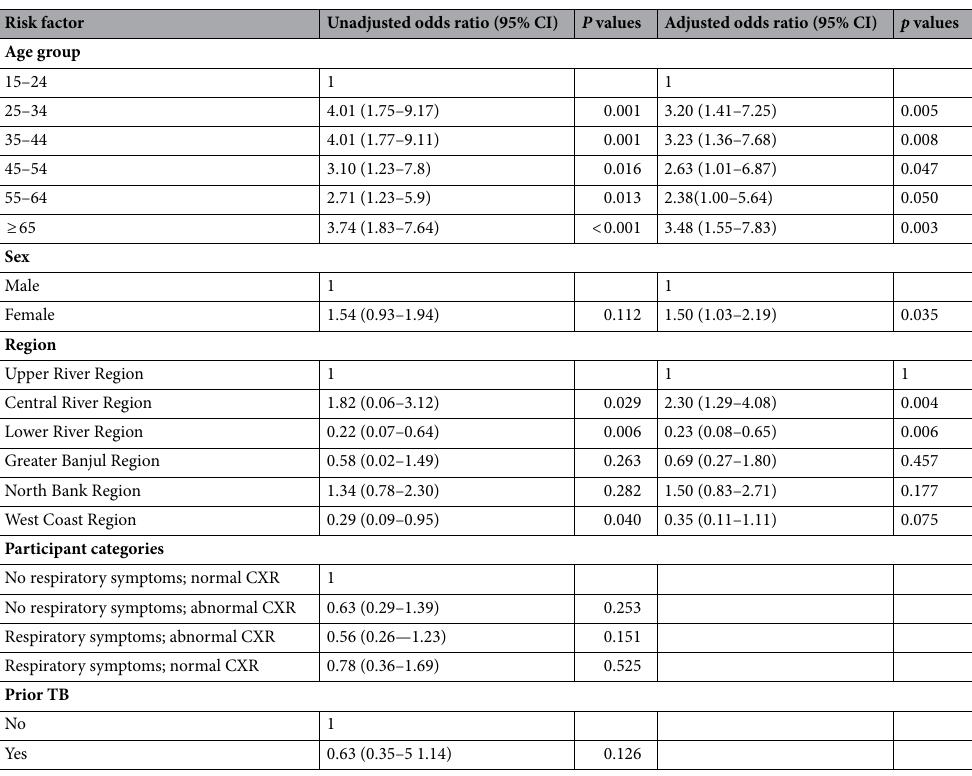
Table 4. Investigating the risk factors associated with pulmonary NTM (n =